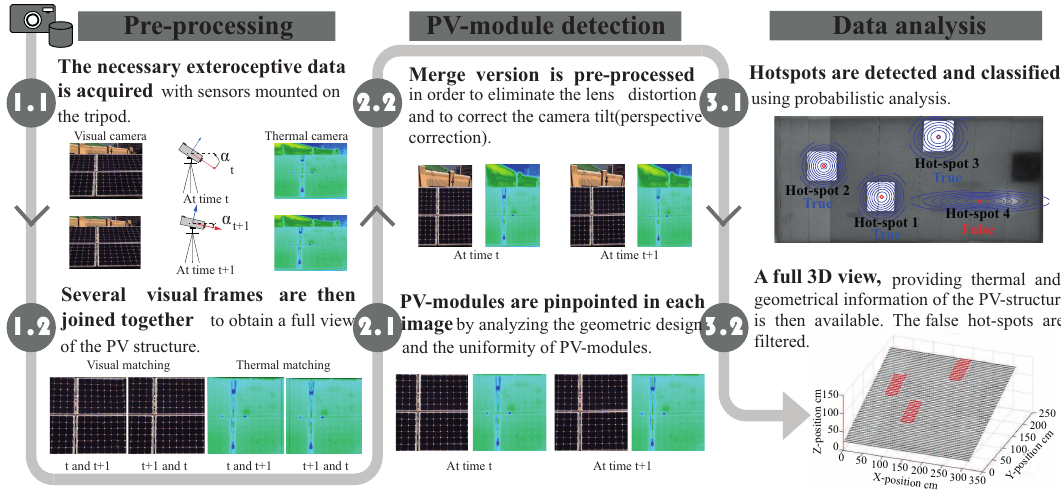
Figure 3. Architecture of the segmentation and inspection system of